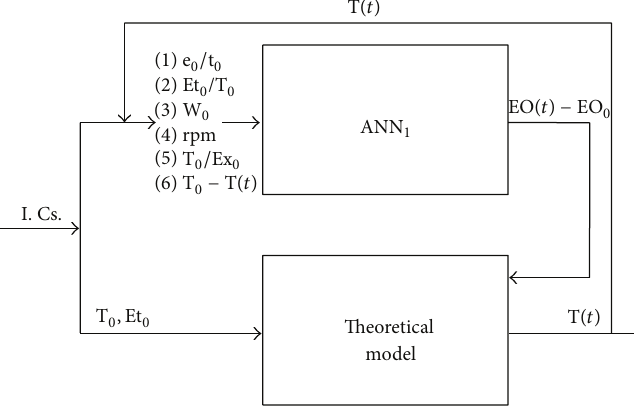
Figure 1: Input-output structure of the developed hybrid neural